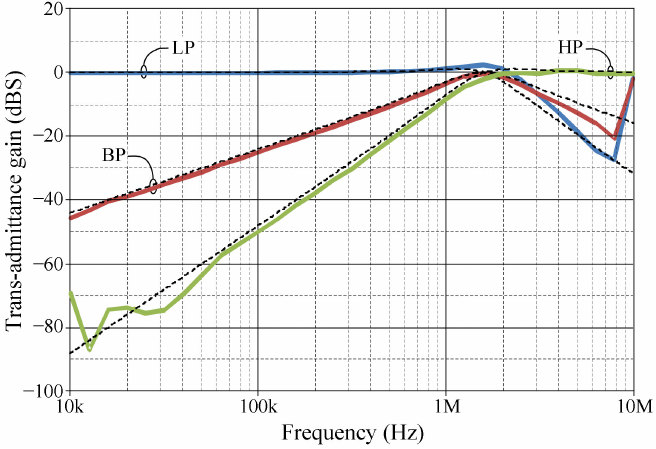
Figure 22. Ideal (dashed line) and measured (solid line) frequency responses for TAM.